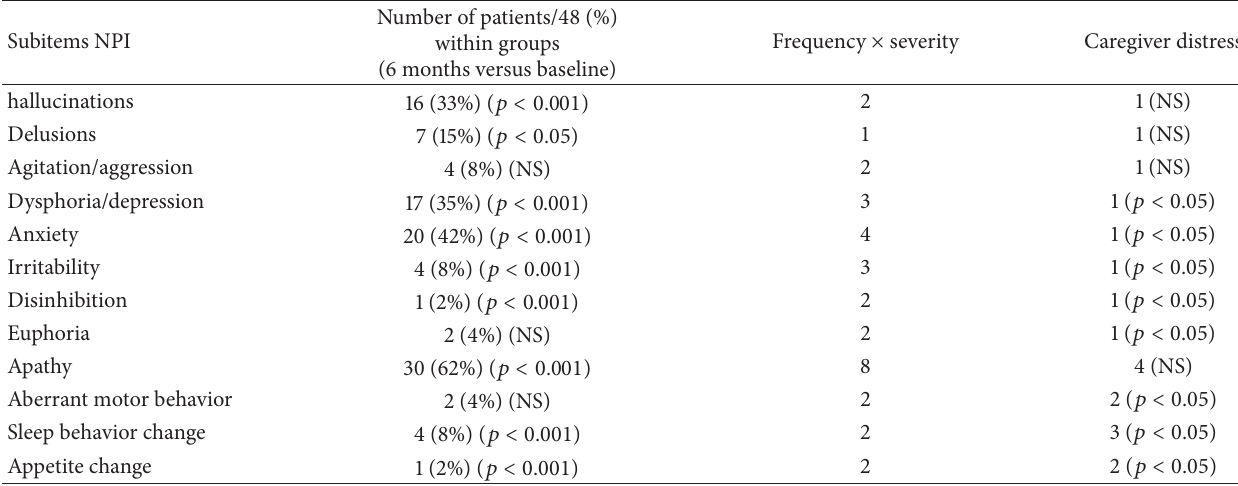
Table 4: 6-month NPI results; in the first and third rows it has been reported the within group comparison with